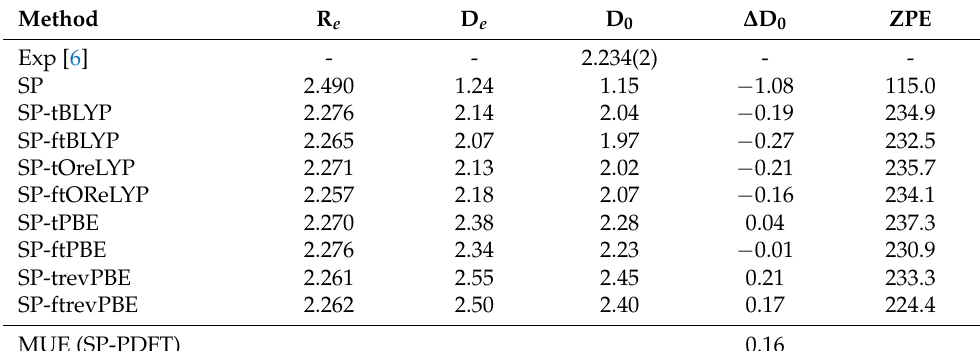
Table 5. Dissociation energies (eV), equilibrium bond lengths (Å), and zero point energies (in cm − 1 ) for VSi in the 4 Π molecular state, computed with a SP wave function.